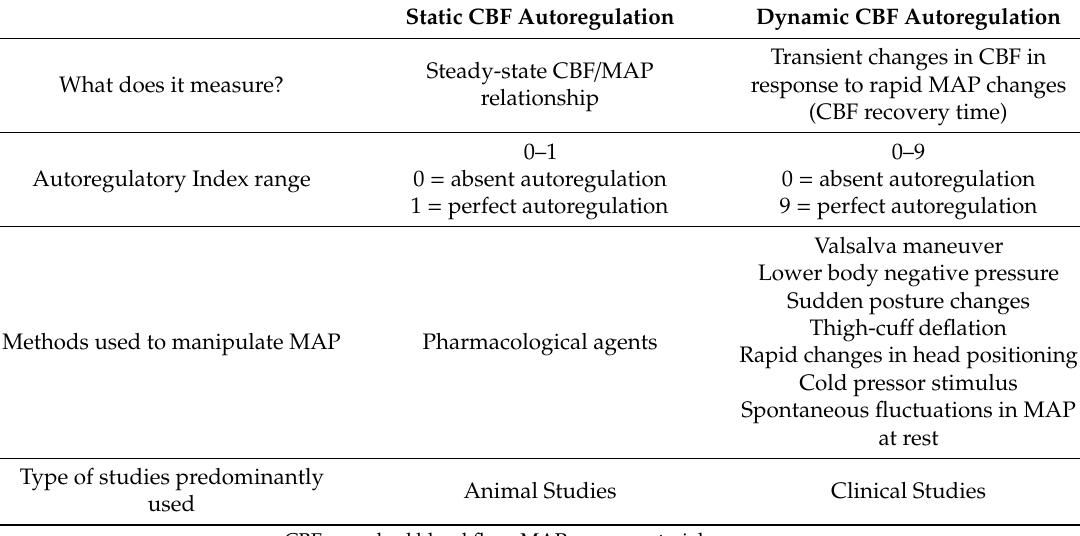
Table 1. Comparison between static versus dynamic CBF